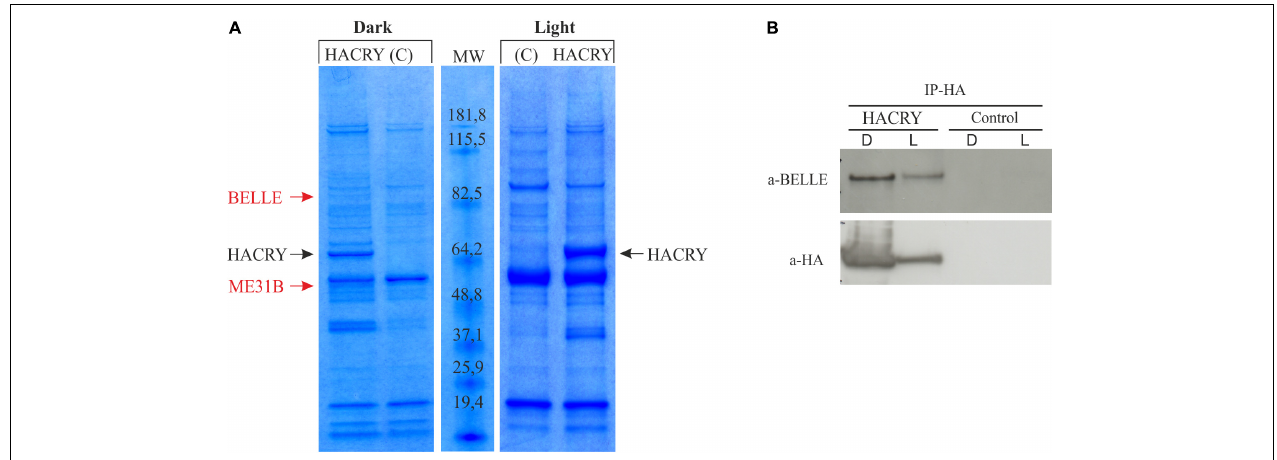
FIGURE 1 | dCRY interacts with BELLE. (A) Coomassie blue-stained gel of heads protein extracts coimmunoprecipitated with an anti-HA antibody. HACRY-overexpressing flies (HACRY, yw;tim-GAL4/+; UASHAcry/+ ) and relative controls (C, yw;tim-GAL4 ) were reared in 12:12 light: dark and collected in the dark (ZT24) and in the light (ZT24 + 15-min light pulse). Molecular masses of markers are indicated (BenchMark Pre-Stained Protein Ladder; Invitrogen). MW, molecular weight. Bands corresponding to HACRY are indicated in black, while stained proteins excised and characterized by mass spectrometry are indicated in red. (B) Co-immunoprecipitation and Western blot confirming the interaction between HACRY and BELLE in HACRY-overexpressing flies (HACRY, yw;tim-GAL4/+; UASHAcry/+ ). tim-GAL4 flies were used as control. Heads were collected as in (A) . Membranes were probed with anti-BELLE and anti-HA antibodies.